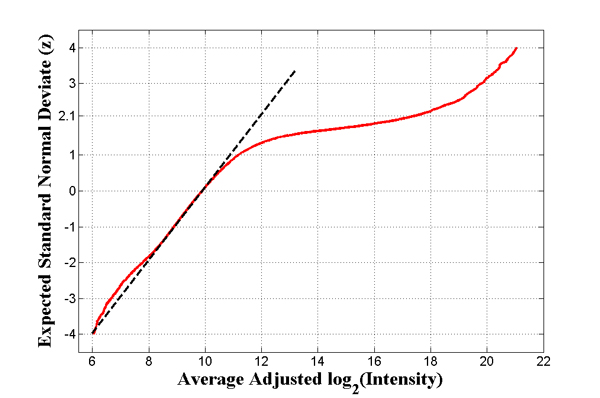
Normal probability plot of the estimates of the adjusted average log-intensities. The red line, actually 31,110 points, is a normal probability plot of the adjusted average log-intensities. The dashed line indicates a normal distribution that roughly approximates the lower values, and it was used to model the background distribution of log-intensities. Our interpretation was that adjusted average log-intensities exceeding 12 represent expressed genes.